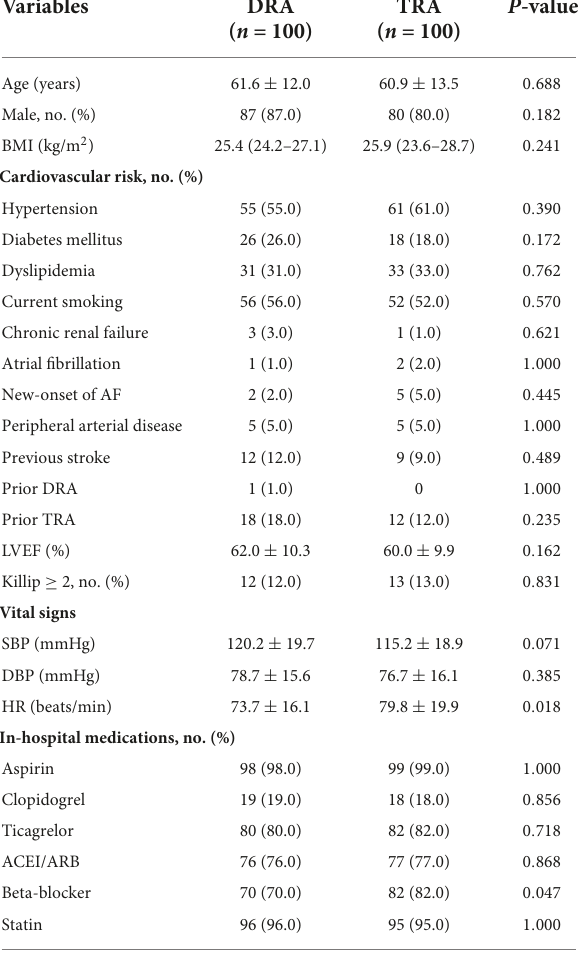
TABLE 1 Patients’ baseline